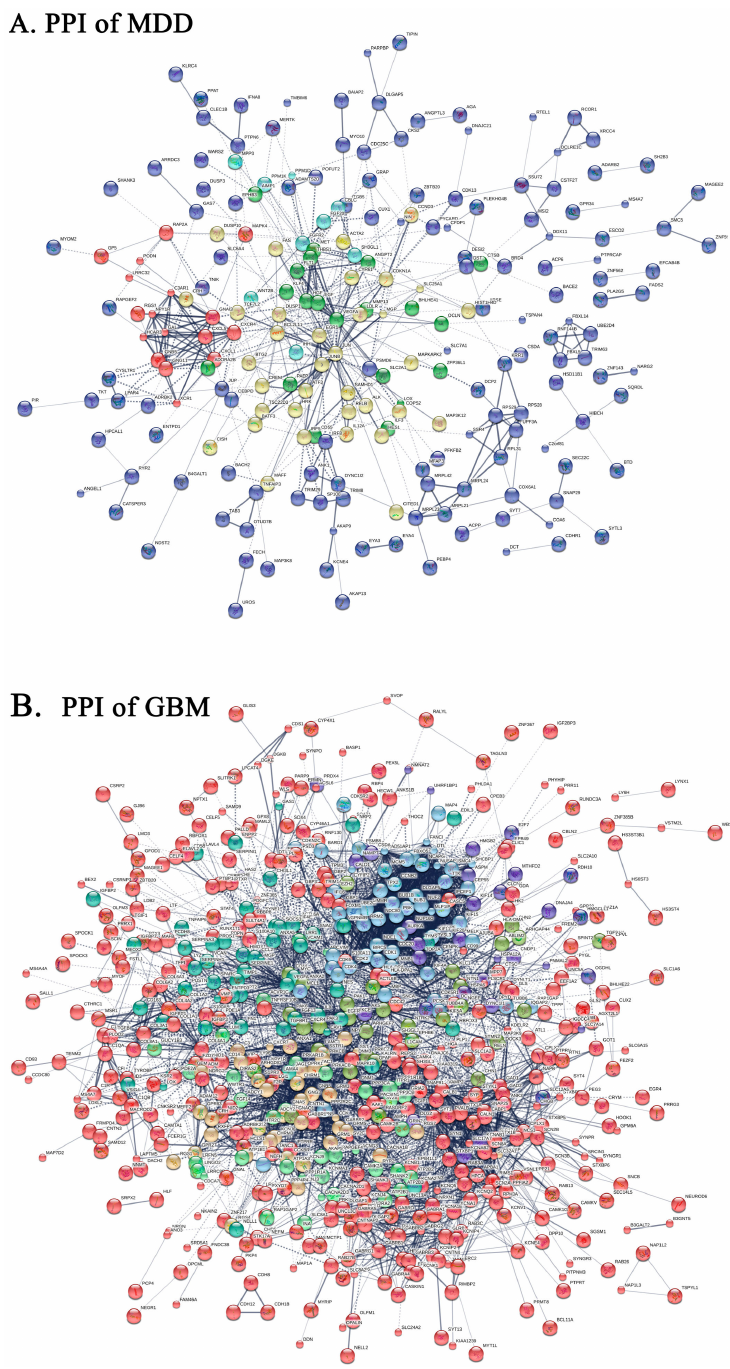
Figure 3. The protein-protein interaction network of MDD and GBM. ( A ) The protein—protein interaction (PPI) of MDD. ( B ) The PPI of GBM. Nodes of the same color represent proteins that are aggregated into the same class; large nodes indicate that the three-dimensional structure of the protein is known and that the small nodes are unknown; the line represents the interaction between proteins; there are seven kinds of relationship. Red, fusion gene; Green, adjacent interaction; Blue, coexistence relationship; Purple, experimental study of validation interactions; Yellow, literature digging to the interaction; and, Light blue, the database included interaction; Black, shared expression. MDD, Major Depressive Disorder. GBM,